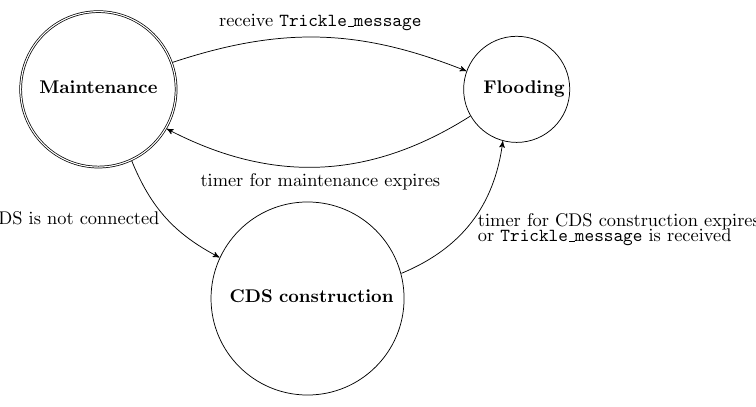
Figure 11. Flooding protocol states. The state transitions are caused by events which can occur when a function is called or when a variable is set. The state Maintenance is the starting state. The function “receives Trickle_message ” handles messages received by